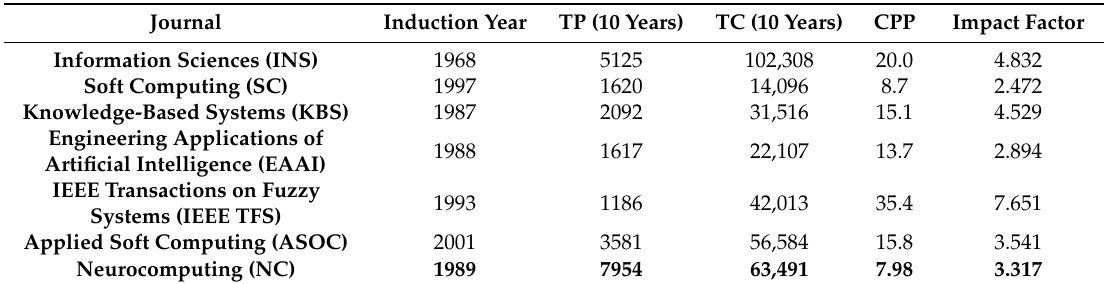
Table 9. Comparison of NC with other related